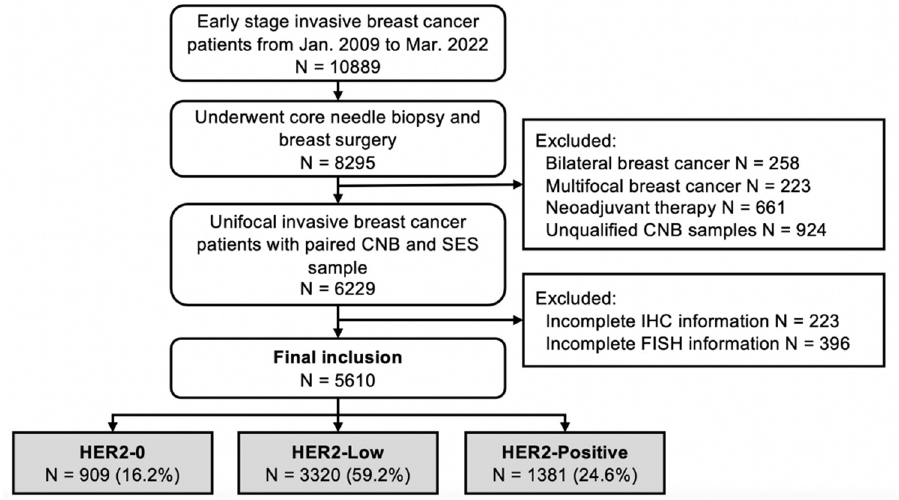
Figure 1. Flowchart of enrolled patients.